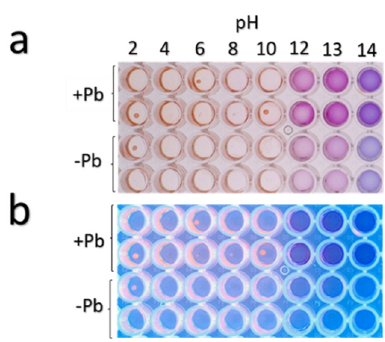
Figure 10. Changes in colorimetric properties of H17’s extracts from fungal cultures with ( + Pb) or without ( − Pb) lead under pH gradient. ( a ) Observed under visible light and ( b ) under UV light (365 nm).